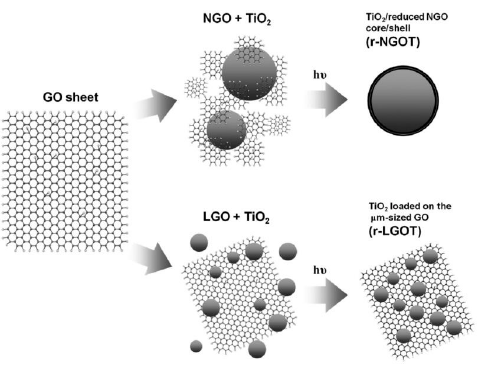
Figure 4. Schematic display of synthetic process of graphene oxide (GO)/TiO 2 and TiO 2 /GO. Reproduced with permission from Reference [57]; copyright (2012), American Chemical Society.